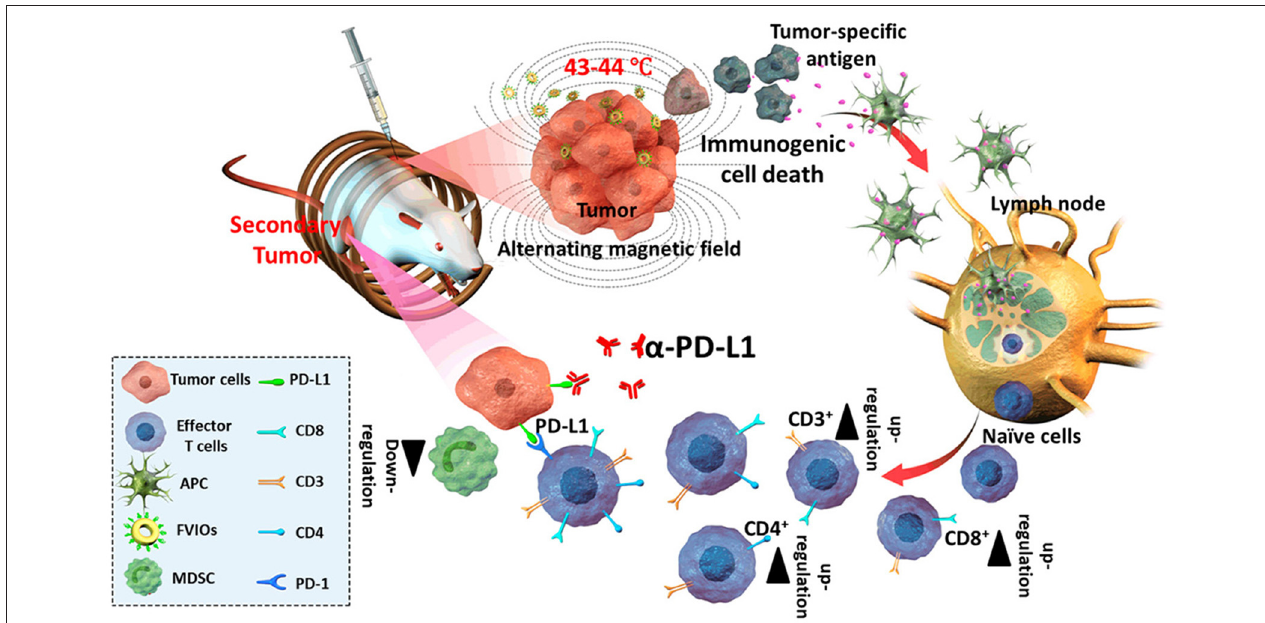
FIGURE 9 | Alternative magnetic field (AMF)-induced hyperthermia and immune therapy. AMF-induced heat triggers immunogenic cell death (ICD) and antigen release in tumors, which further induces cytotoxic T lymphocyte activation, and the combination with checkpoint blockade activates antitumor immune therapy. Reproduced from Liu et al. (2019b) Copyright © 2019, American Chemical Society